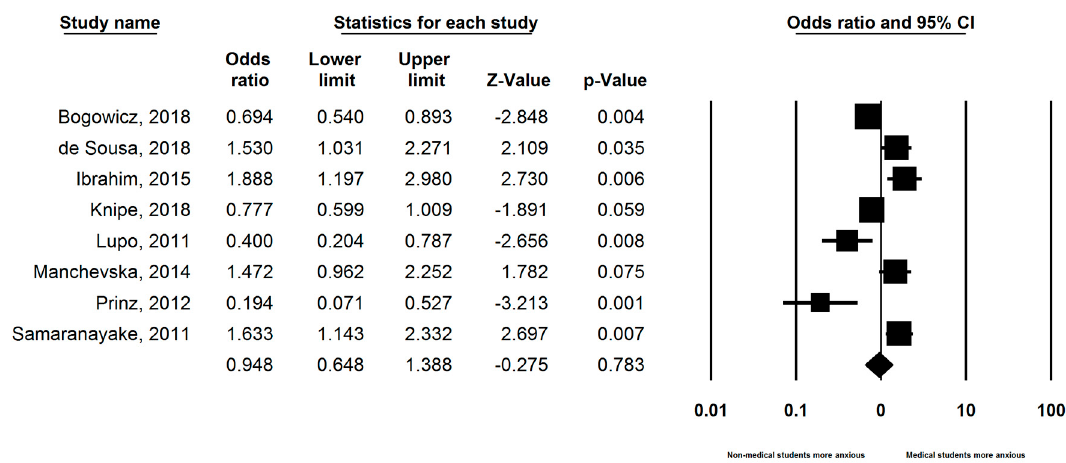
Figure 3. Forest plot of studies (n = 8) comparing the prevalence of anxiety between medical and non-medical students.